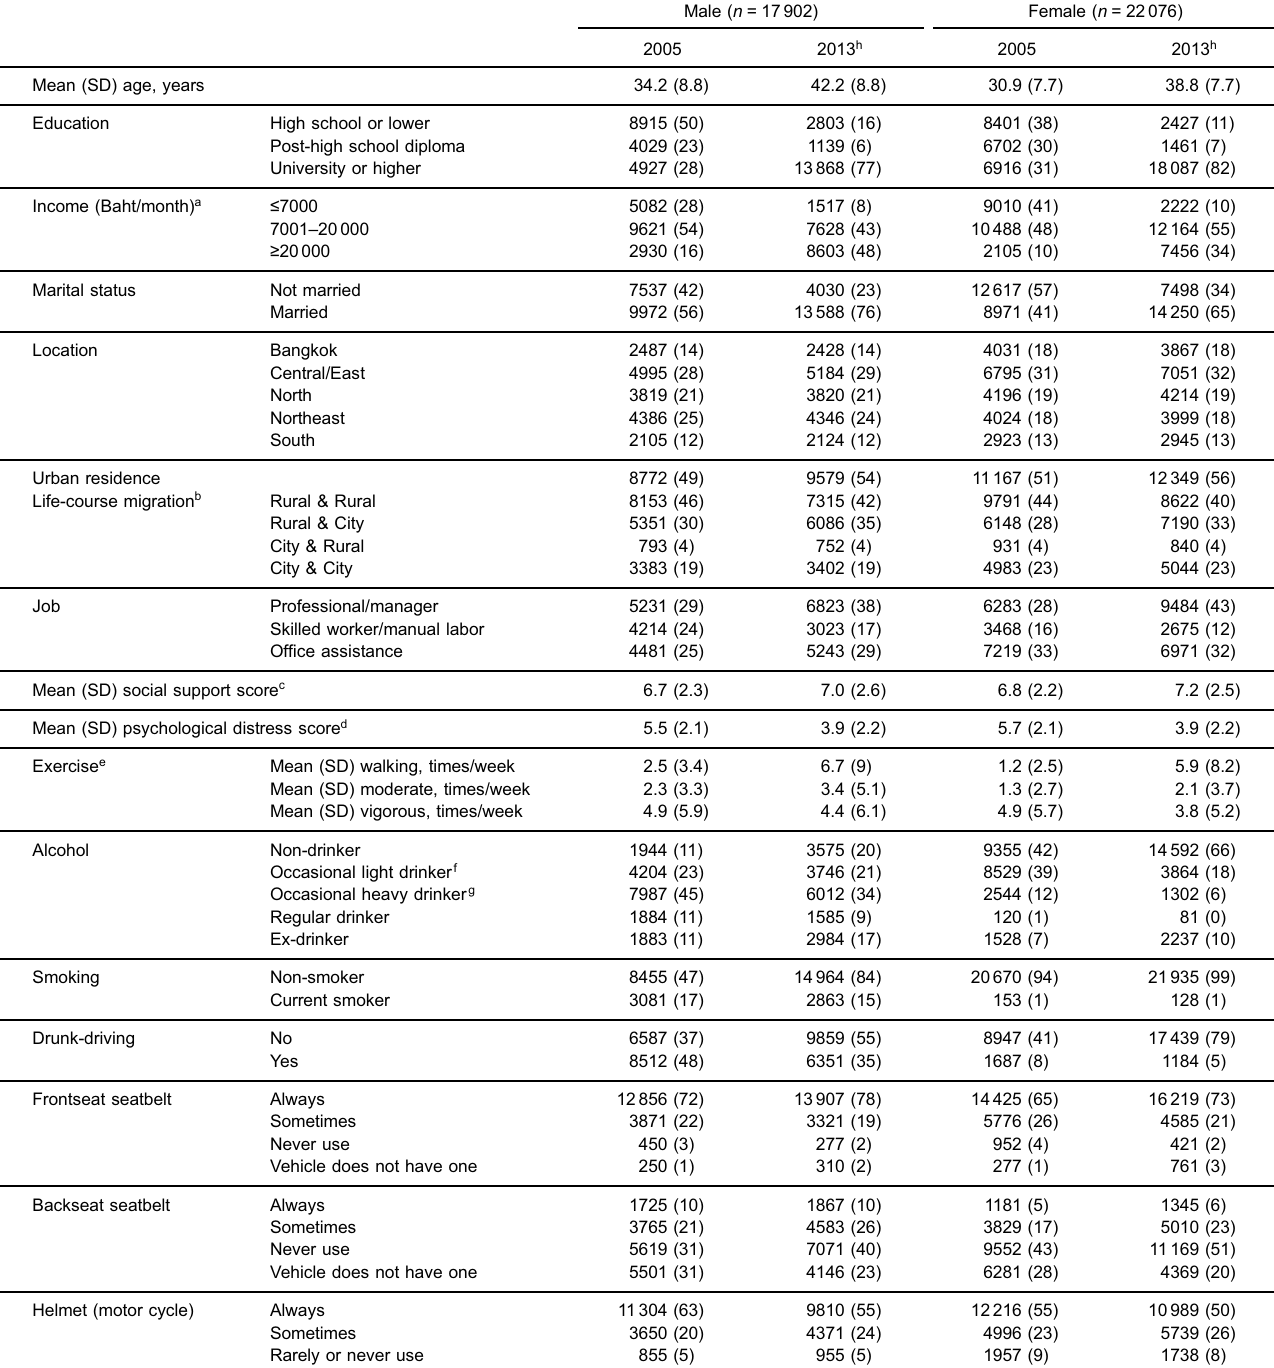
Table 1. Characteristics of Thai Cohort members ( n = 39978) in 2005 and